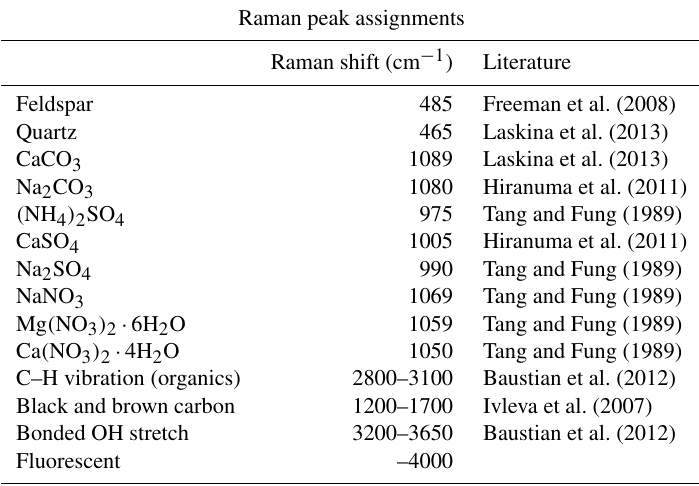
Table 1. Peak assignments for Raman spectra obtained in this